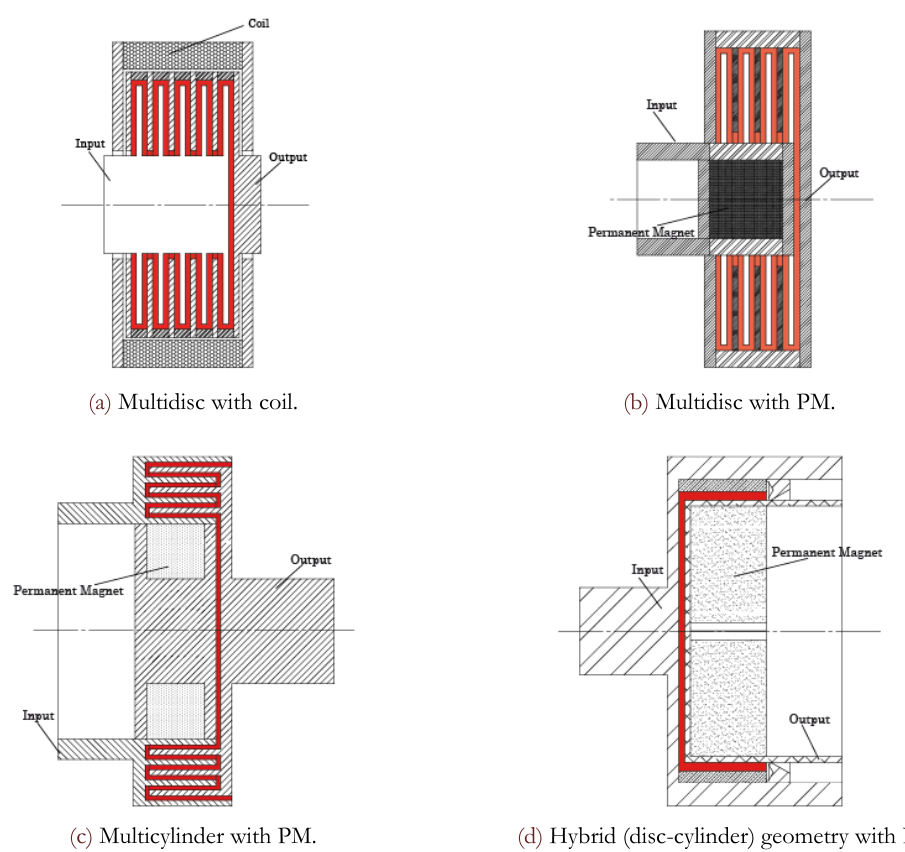
Figure 4: Preliminary design of the MR